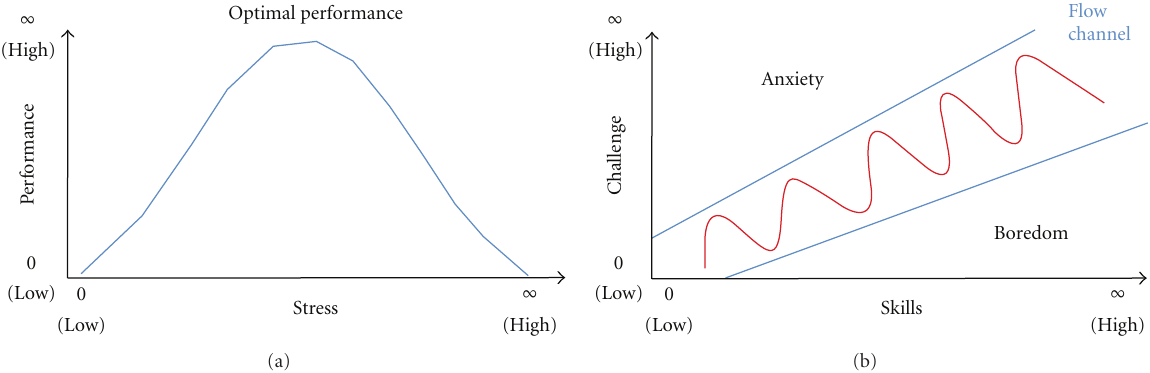
Figure 4: Design principles of the personalization of training with the NTT. (a) Yerkes-Dodson law established an inverted U-curve dependence between stress level and task performance. (b) Flow theory places the maximum user engagement in the balance between skills and challenge in a given task, described as the flow channel. See text for further